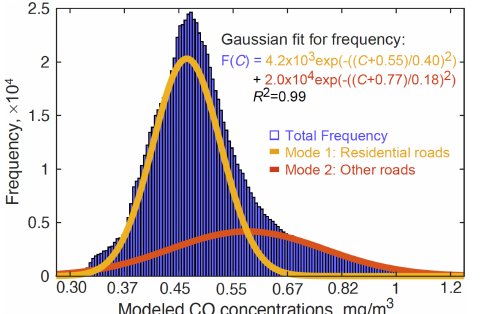
Figure 4. Frequency distribution of modeled ground-level CO con- centrations during rush hours under the east wind and 6.5ms − 1 at the top of boundary layer. The distribution is fitted with a two-mode Gaussian model. The yellow (residential streets) and orange (arte- rial roads, highways, and the nearby regions) curves represent the two Gaussian modes.